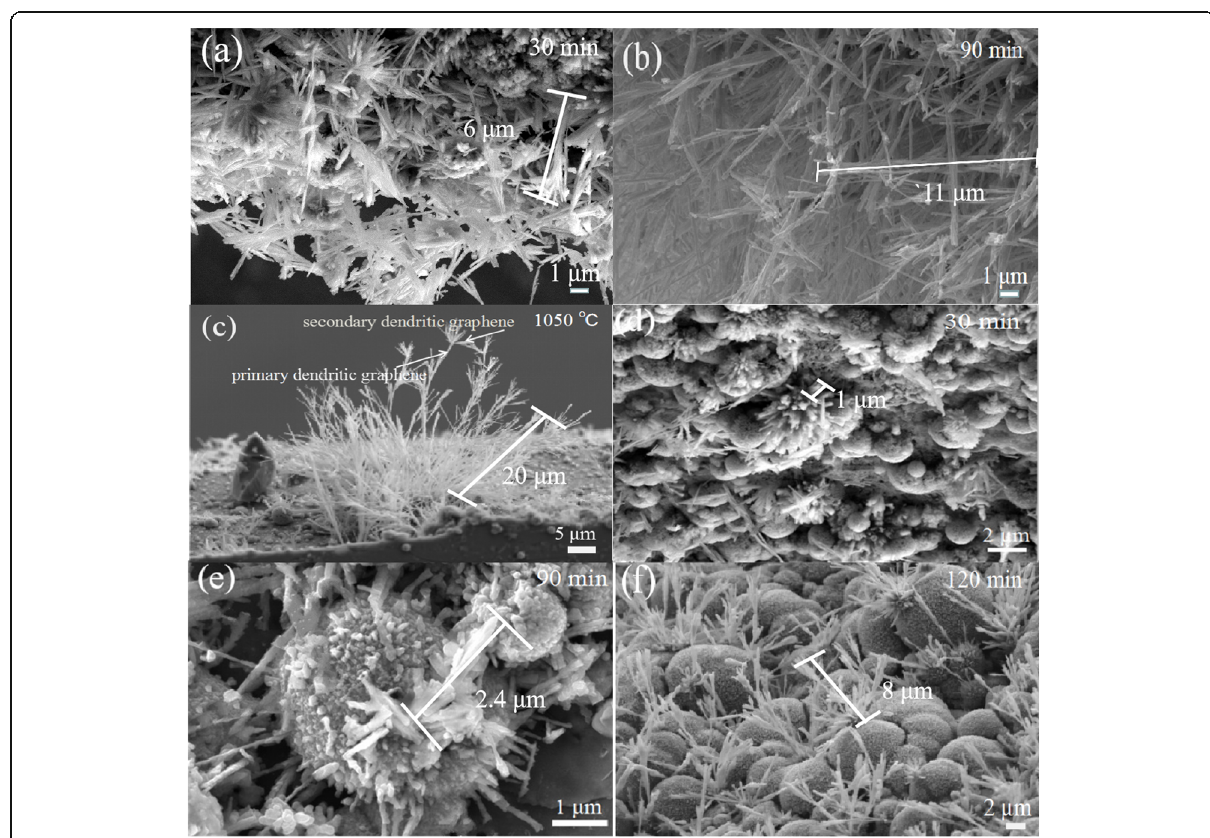
Fig. 3 SEM images of tree-like graphene dendrites synthesized on the Si surface ( a – c ) and on the SiO 2 surface ( d – f ) of the SiO 2 /Si substrates for the different growth time from 30 to 120 min at 1050